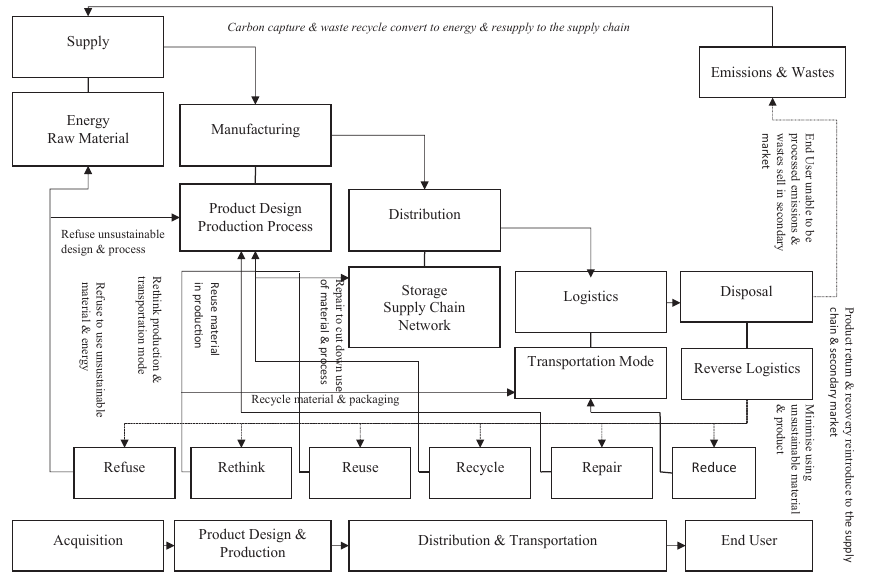
Figure 2. Circular economy RL